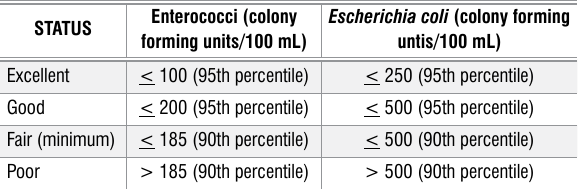
Criteria for recreational use of coastal waters in South Africa 34 STATUS